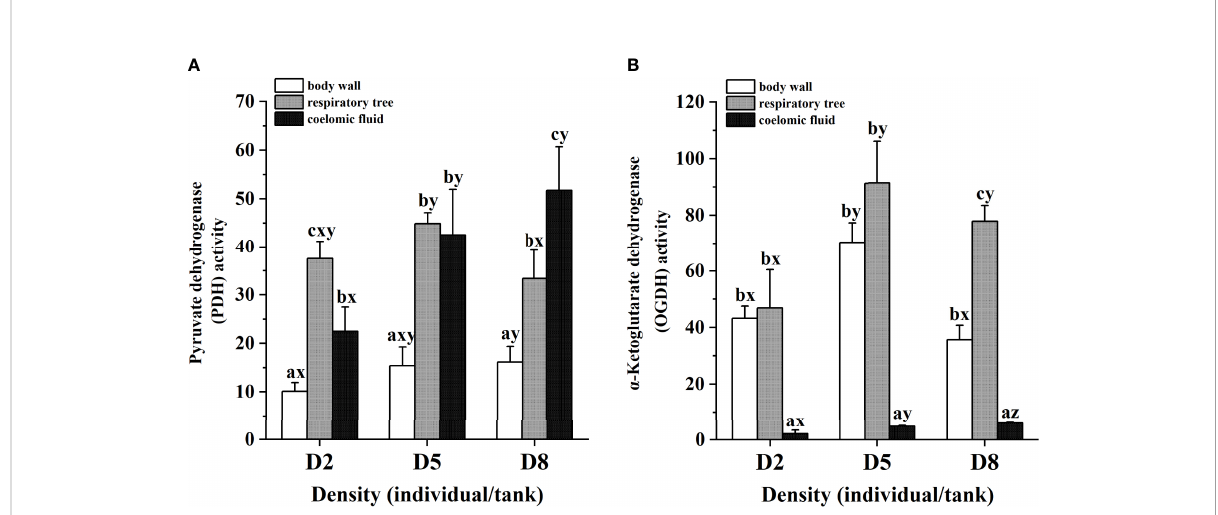
FIGURE 2 Pyruvate dehydrogenase enzyme activity (A) and a -ketoglutarate dehydrogenase enzyme activity (B) of sea cucumber at different stocking densities and tissues. Different letters a, b and c in the same density represented signi fi cant differences among different tissues ( P < 0.05), and letters x, y and z at the same tissue represented signi fi cant differences among different densities ( P < 0.05) and bars represented standard deviation. The enzyme activities units were U/g in respiratory tree and body wall tissues, and U/mL in coelomic fl